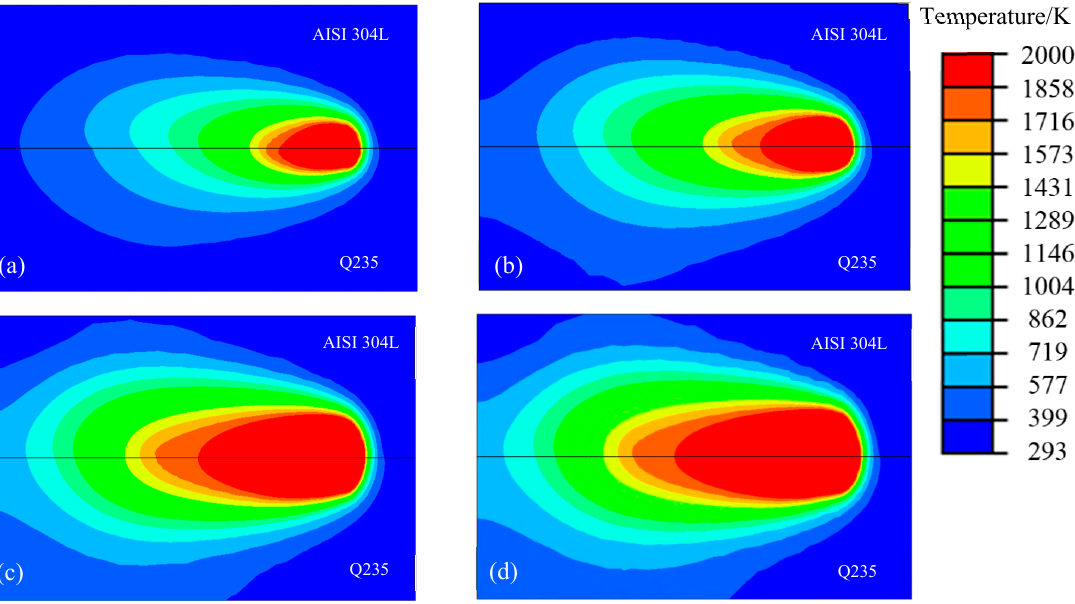
Figure 10. The top views of the simulation results: ( a ) laser power = 1 kW; ( b ) laser power = 1.5 kW; ( c ) laser power = 2 kW; ( d ) laser power = 2.5 kW.